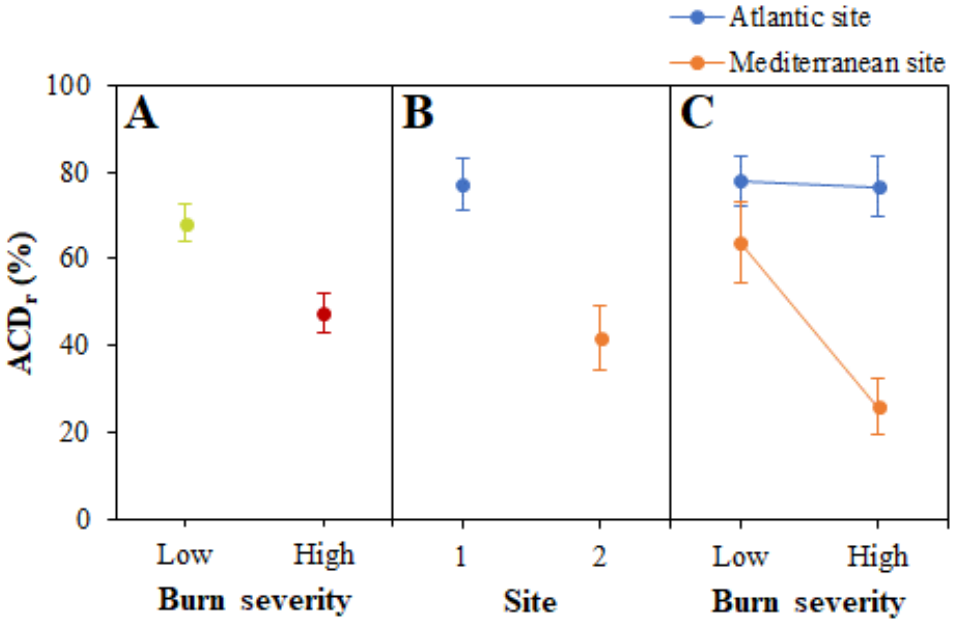
Figure 5. Predicted aboveground carbon stocks recovery (ratio of post-fire to pre-fire aboveground carbon density; ACD r ) of living shrub biomass (mean ± 95% confidence intervals) as a function of burn severity ( A ), environmental conditions ( B ) and the interaction of both factors ( C ).